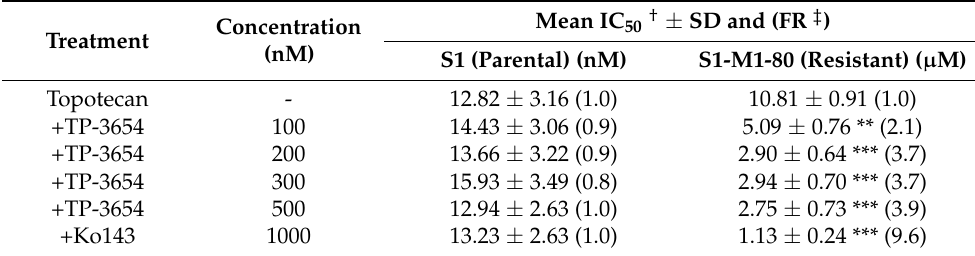
Table 3. Chemosensitizing effect of TP-3654 on ABCG2-mediated multidrug resistance in ABCG2- overexpressing human cell